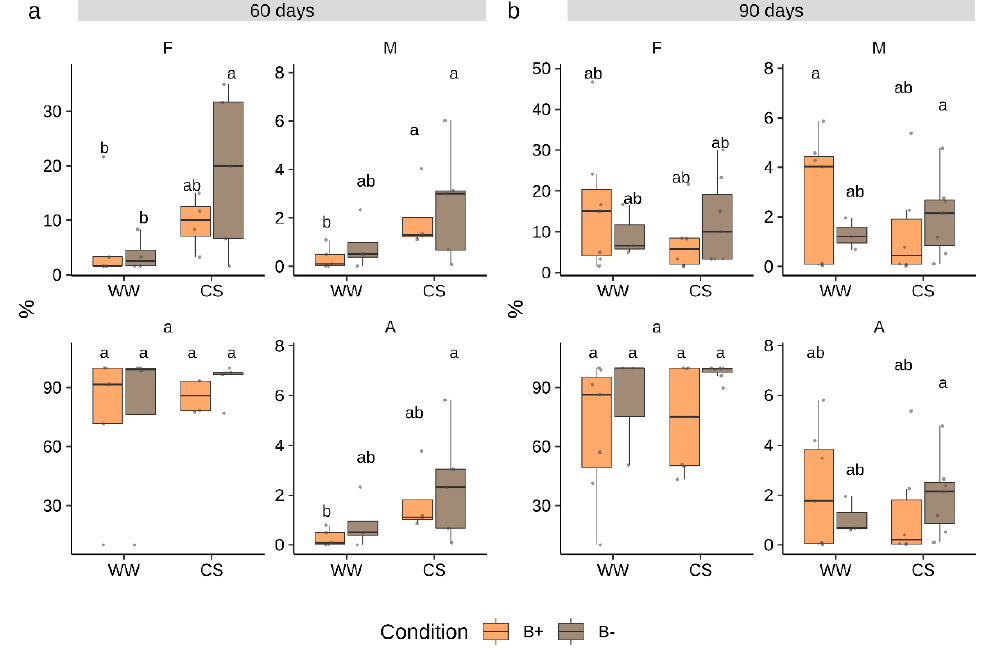
Figure 1. Colonization parameters in Solanum lycopersicum cv. M82 inoculated with Gigaspora margarita at 60 ( a ) and 90 ( b ) days. Statistically supported di ff erences between mycorrhizal (B − and B + ), stress conditions and time points are indicated with di ff erent letters (Kruskal–Wallis test, p < 0.05). F% = frequency of mycorrhization, M% = intensity of mycorrhization, a% = arbuscules abundance in colonized fragments, A% = arbuscules abundance in whole root apparatus. Boxplots display median value (horizontal line), quartiles (boxes) and 1.5 × interquartile ranges (whiskers).